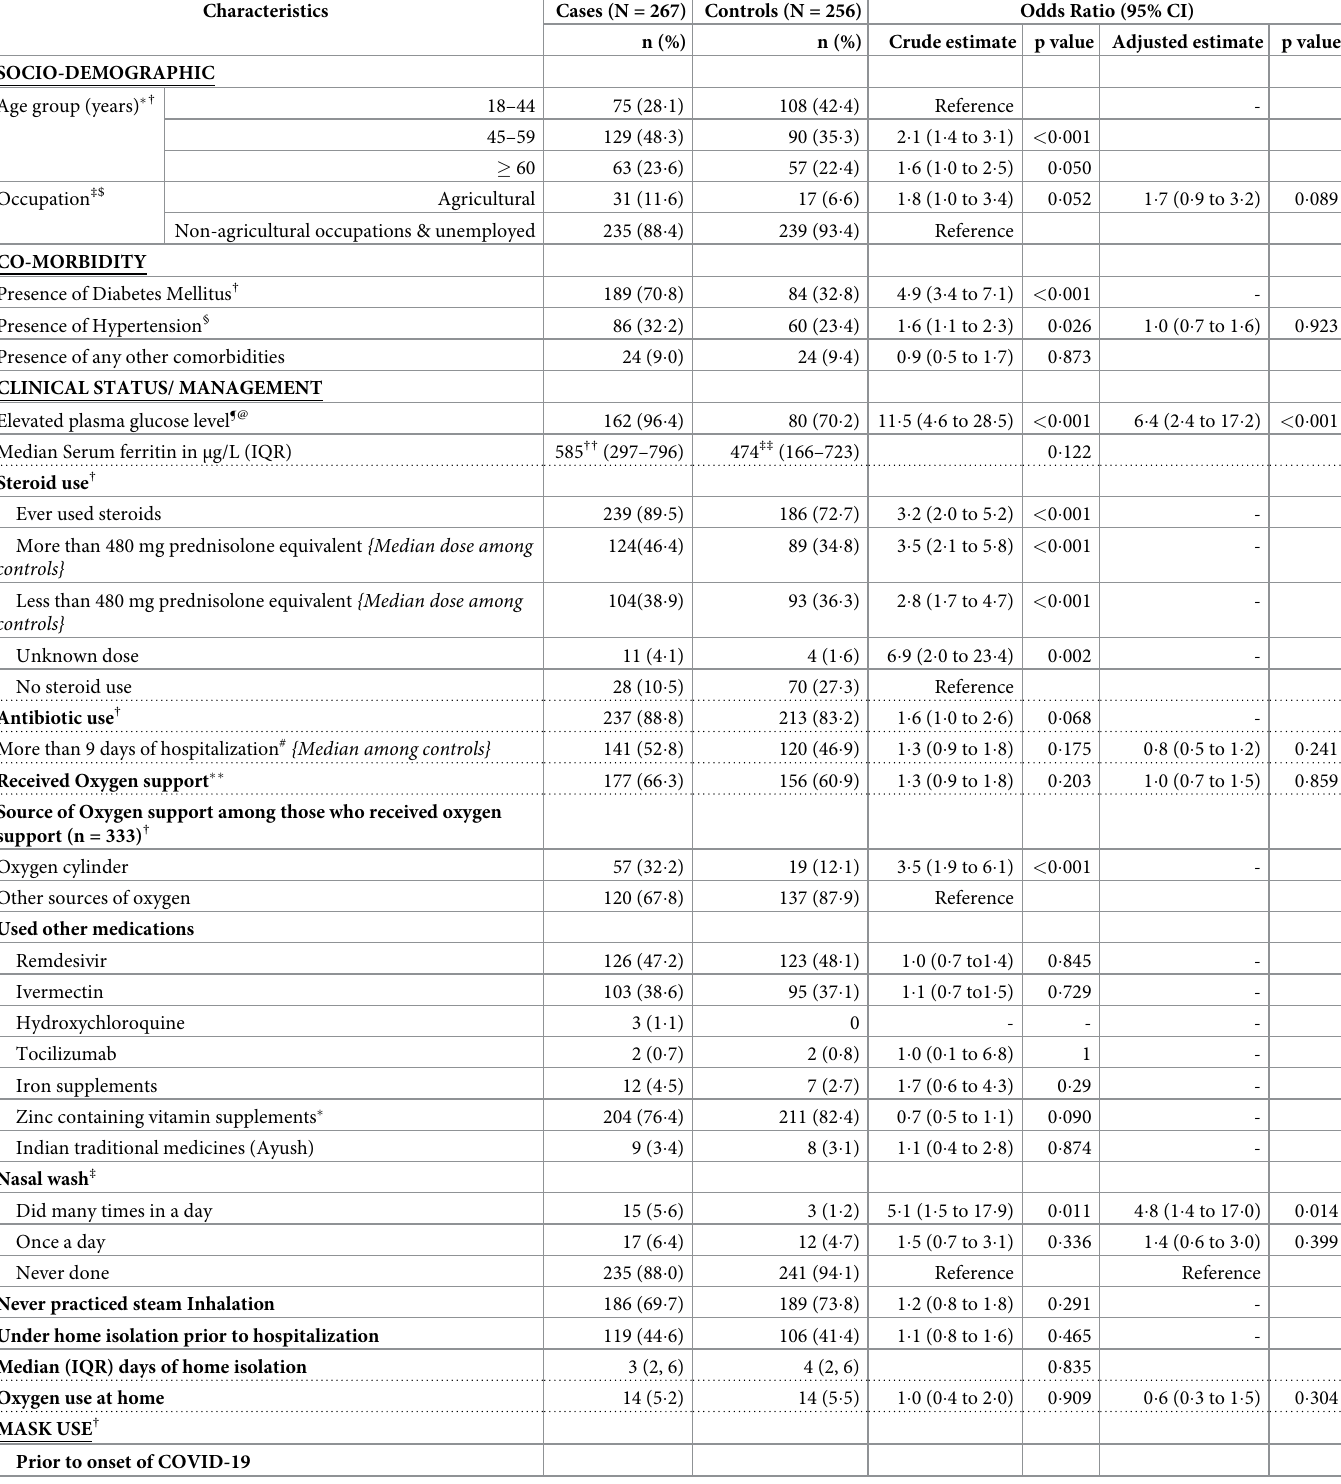
Table 2. Risk factors for mucormycosis among ever-hospitalised COVID-19 patients, multi-centric case-control study of post-COVID rhino-orbito-cerebral mucormycosis, India,